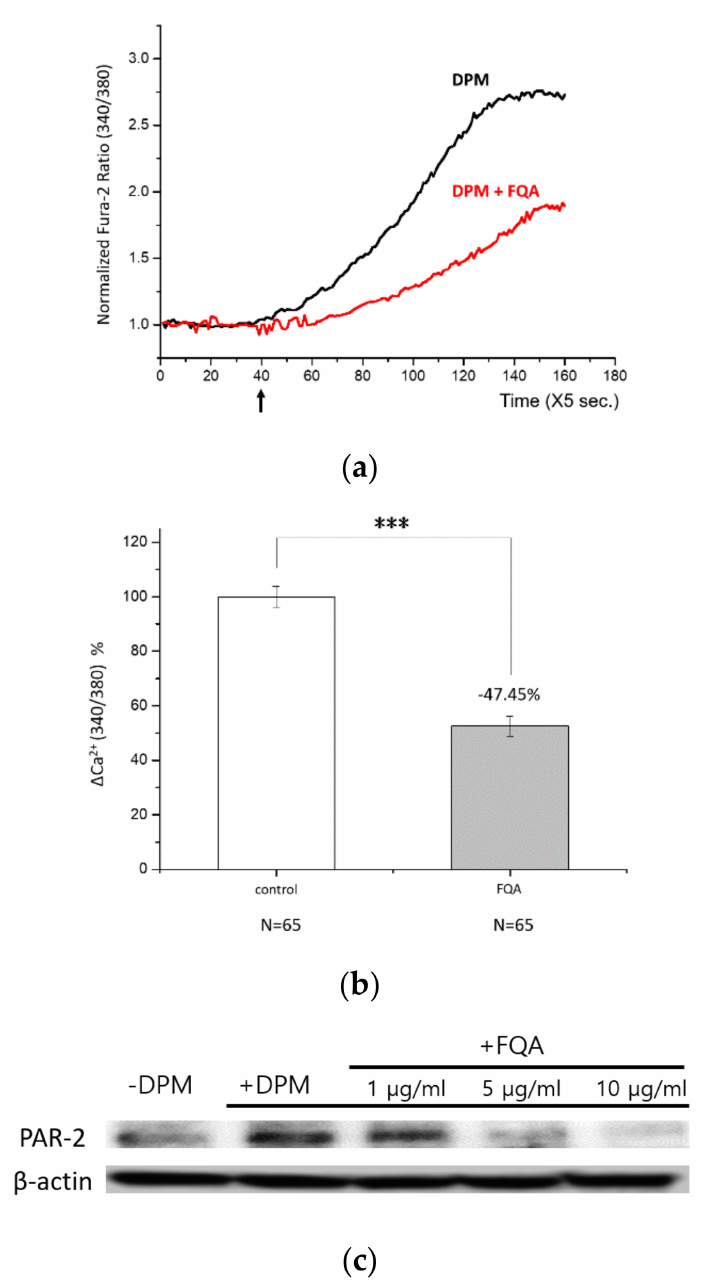
Figure 7. 4-O-feruloylquinic acid (FQA) is a major determinant of protective function of PAE. ( a ) HaCaT cells were treated with DPM only (black) or DPM and 100 ppm FQA (red) at the indicated time (arrow). ( b ) DPM-induced Ca 2+ influx was significantly reduced by FQA, hardly distinguishable from the effect of PAE. ( c ) The regulation of PAR-2 upon the DPM treatment was countered by FQA in a concentration-dependent manner. (*** p <